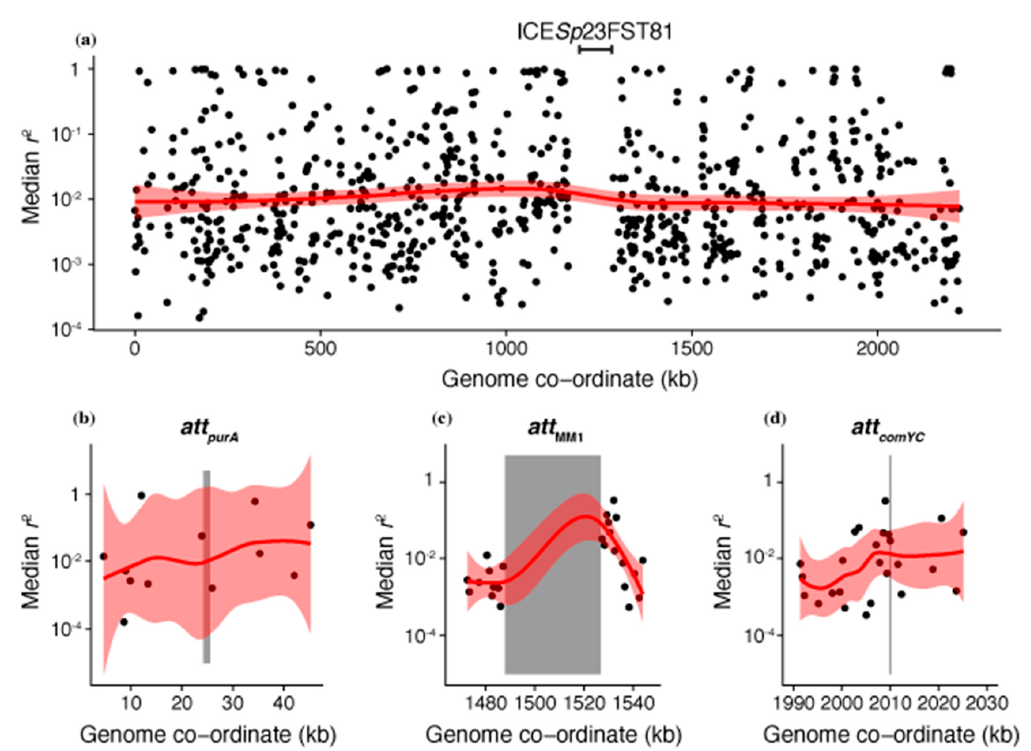
Figure 3. Linkage disequilibrium across the S. pneumoniae chromosome, calculated from a species-wide sample of 4127 isolates [39]. A median pairwise r 2 could be calculated between all biallelic single nucleotide polymorphisms with a minor allele frequency above 1% for 904 of the 1447 core genes. The higher r 2 values reflect greater disequilibrium, and therefore lower levels of recombination. ( a ) Genome-wide pattern of linkage disequilibrium. The median r 2 for each core gene is shown relative to its position in the S. pneumoniae ATCC 700669 genome, the reference isolate for the PMEN1 lineage [57]. The conjugative element, ICE Sp 23FST81, is marked as the explanation for the absence of core genes in one segment of the genome. The red line shows the LOESS local regression line, with the 95% confidence interval shaded. ( b – d ) Detailed view of the linkage disequilibrium statistics for the core genes surrounding the prophage att sites highlighted in Figure 2. The att positions are indicated by vertical grey stripes; att MM1 contains an inserted prophage, whereas the others are empty in this genome. The smoothed LOESS regression line segments for these regions are shown in red.